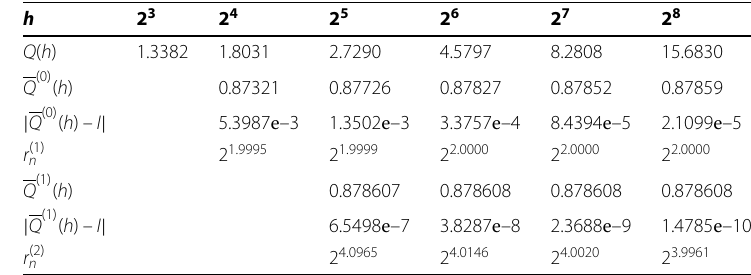
Table 3 The numerical results for t = 0.25